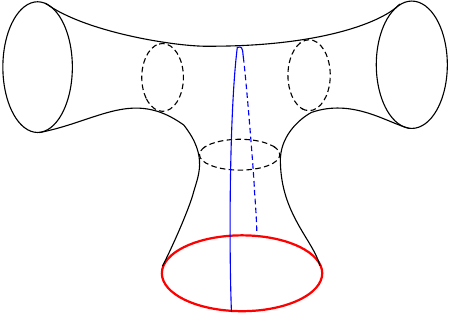
Figure 21 . A two-boundary long wormhole obtained from a three-boundary wormhole with an EOW brane (red). The blue surface is the extremal surface which measures the maximal cross section of the